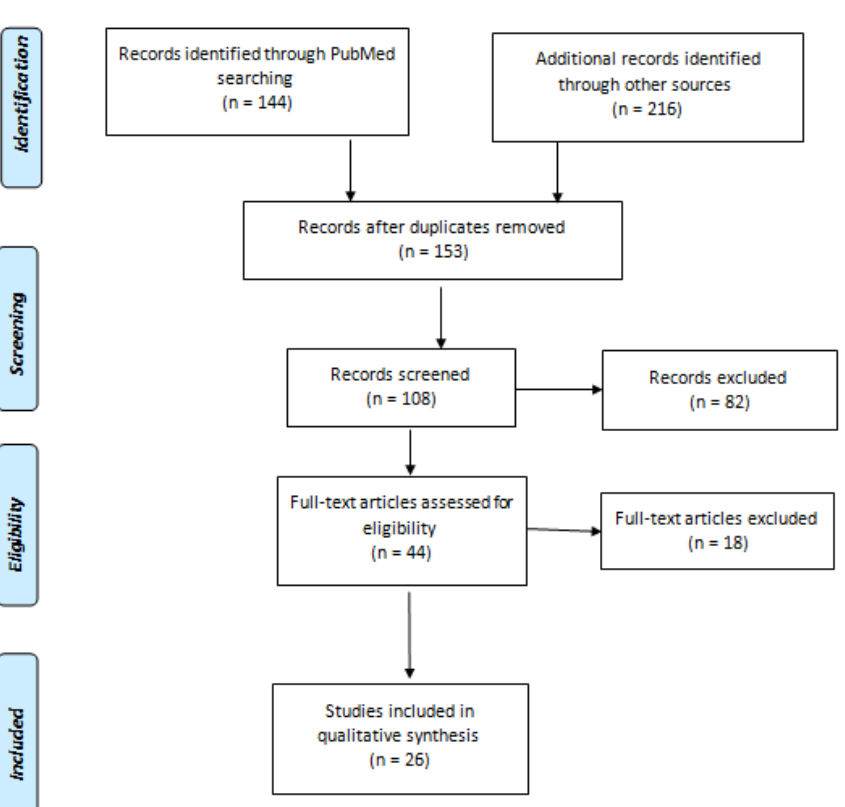
Figure 1. PRISM flow diagram used to select the reported studies for review.